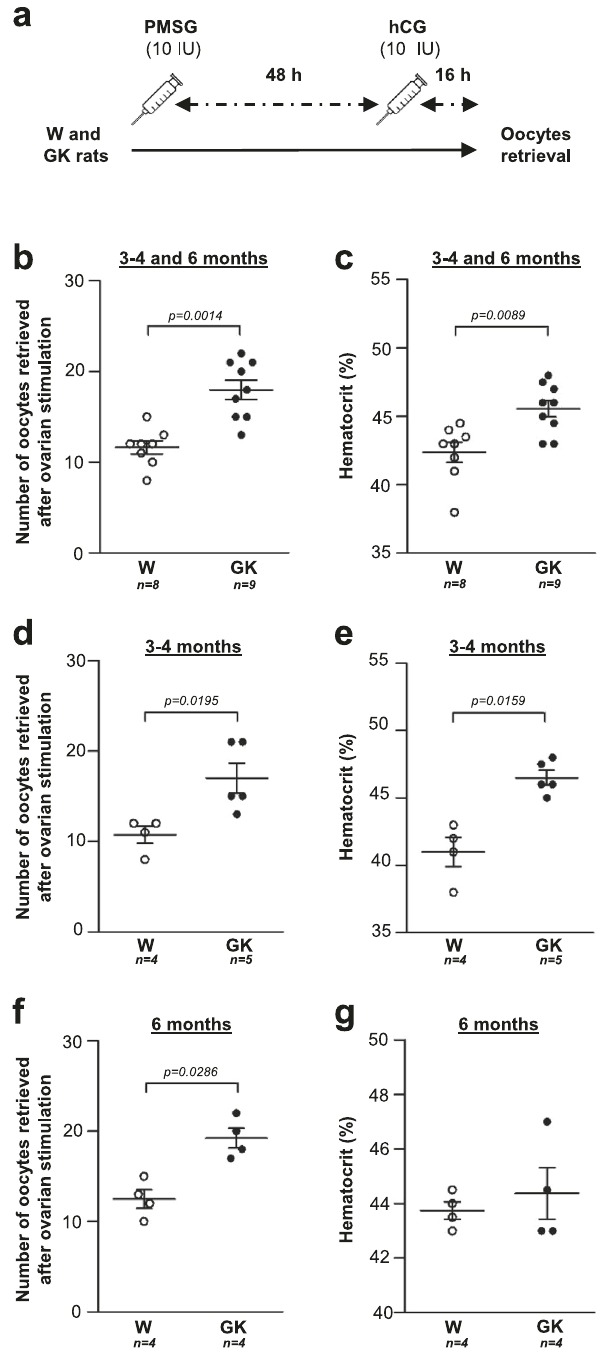
Fig. 7 Ovarian gonadotropin stimulation of Wistar and GK rats. a 3 – 4 and 6 month-old Wistar (W, open symbols) and GK (closed symbols) rats were injected with 10 IU of PMSG followed 48 h later with 10 IU of hCG to induce ovulation. b , d , f Number of oocytes retrieved after ovarian stimulation in Wistar and GK rats. c , e , g Hematocrit in Wistar and GK rats. Panels b , c show the combined results for 3 – 4 and 6 month-old rats; and panels d , e and f , g represent results for 3 – 4 and 6 month-old rats, respectively. Data are represented as scatter blot with mean ± SEM. p -values are from two- sided Mann – Whitney U test for unpaired comparisons (GK vs. Wistar rats). n represents the number of biologically independent animals in each group. Source data are provided as a Source Data fi